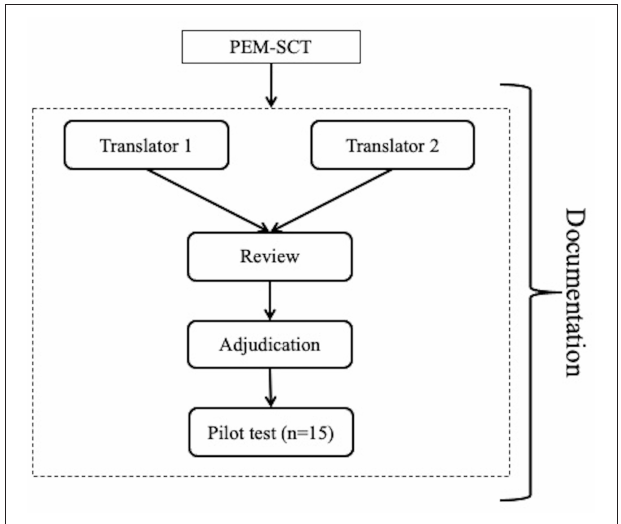
FIGURE 1 | Translation, review, adjudication, pretest, documentation team model for the development of the Japanese version of the pediatric emergency medicine script concordance